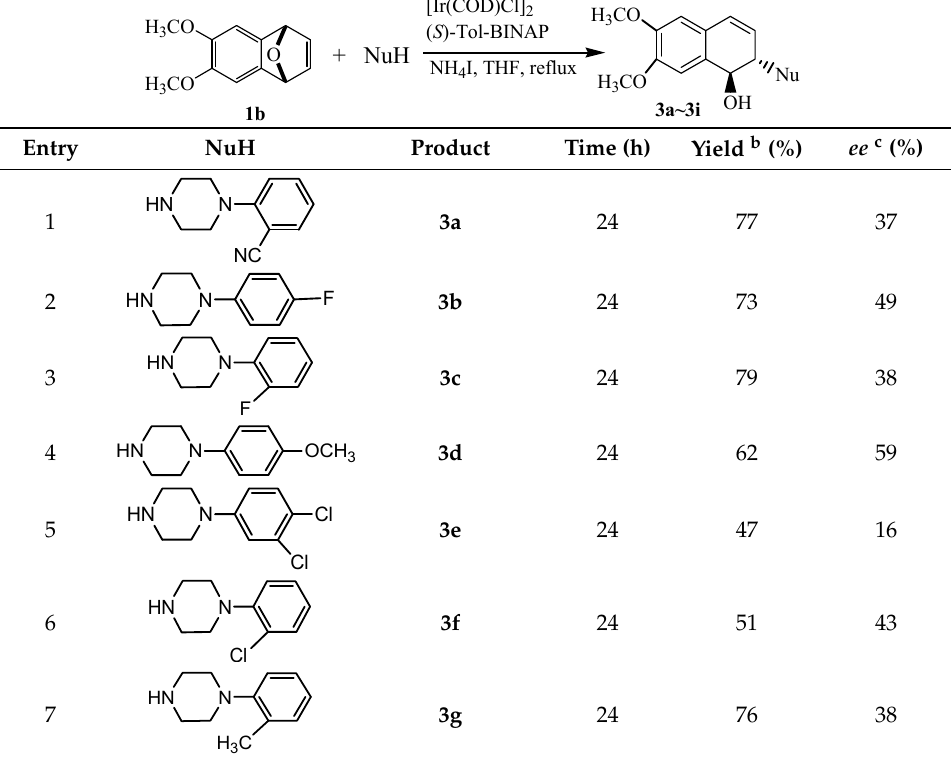
Table 4. Iridium-catalyzed asymmetric ring-opening of oxabenzonorbornadiene 1a with N -substituted piperazines a .